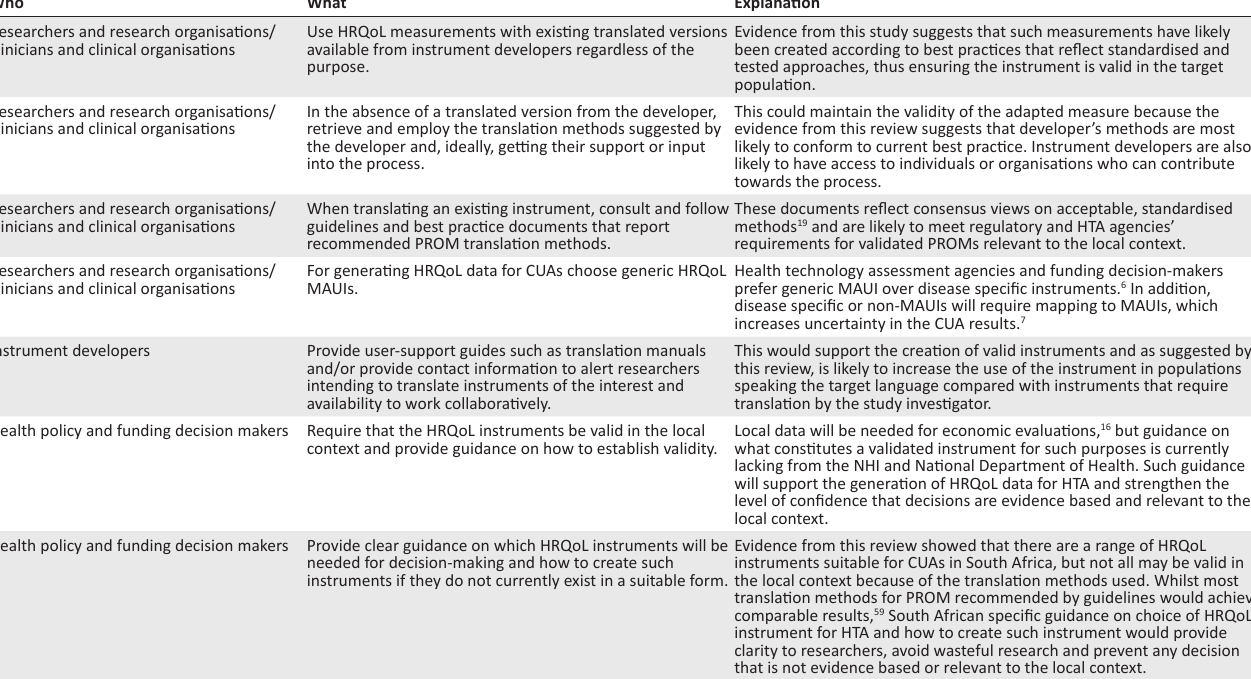
TABLE 4: Recommendations for conducting health-related quality of life research and using health-related quality of life instruments for clinical and policy decision- making in multicultural settings.